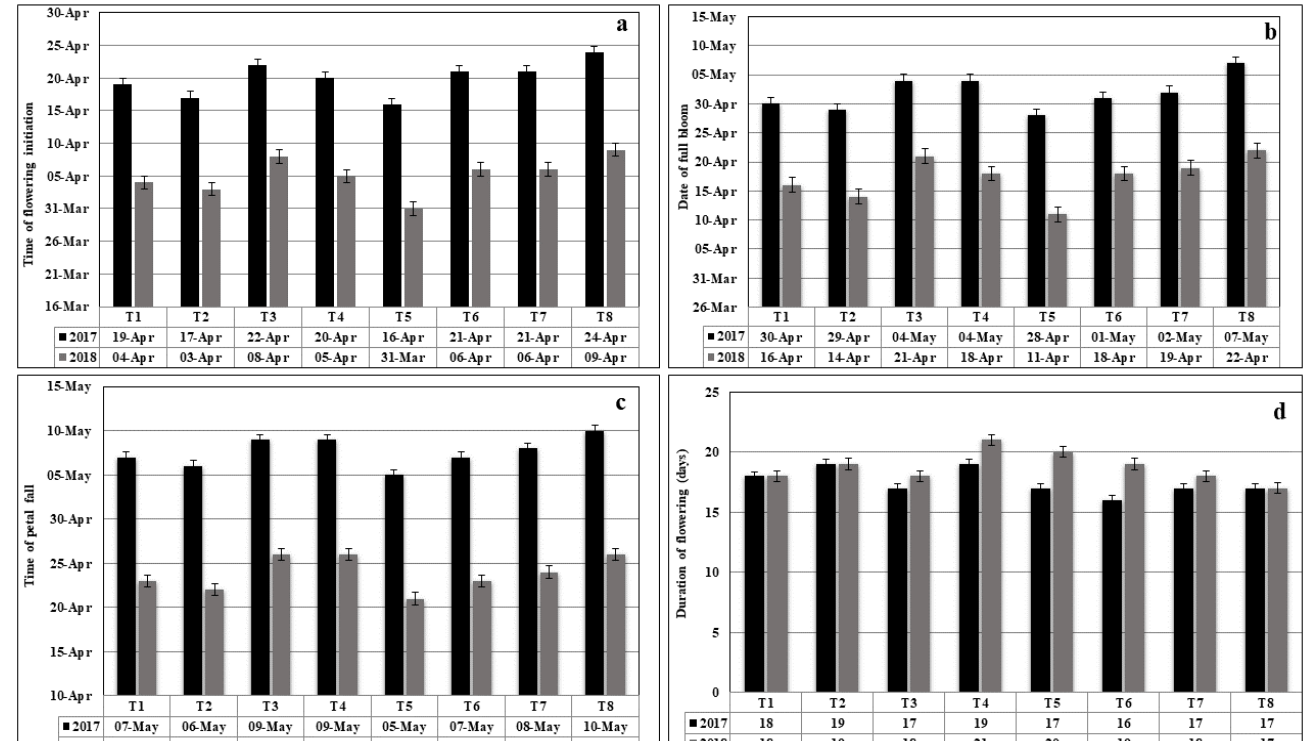
Figure 2. Impact of organic manures on ( a ) time of flower initiation ( b ) date of full bloom ( c ) time of petal fall; ( d ) duration of flowering of Actinidia deliciosa cv ‘Allison’.